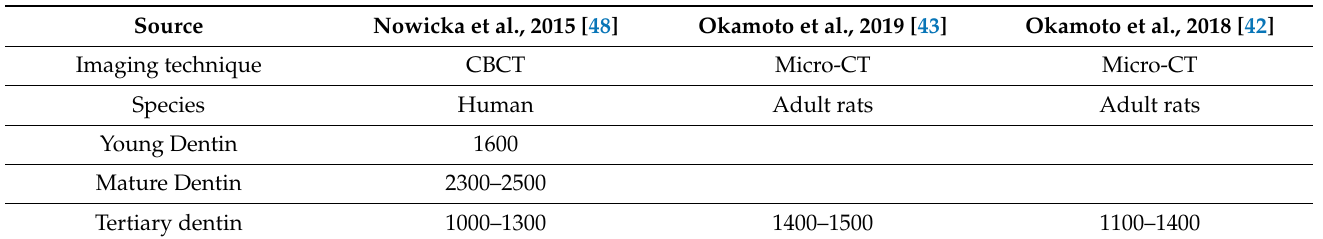
Table 9. Dentine mineral density (mg/cm 3 ) in CBCT and micro-TC analyses in different